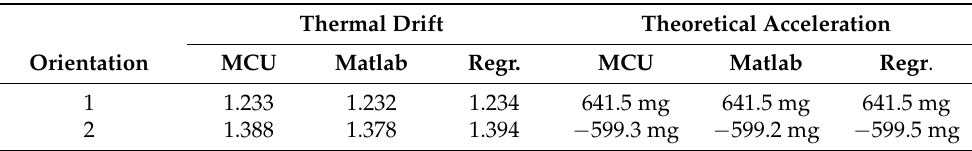
Table 5. Data obtained with the three methods: Microcontroller Algorithm (MCU), Matlab ® Algo- rithm (Matlab), and MatLab ® Linear Regression (Regr.). Thermal Drift Theoretical Acceleration Orientation MCU Matlab Regr.